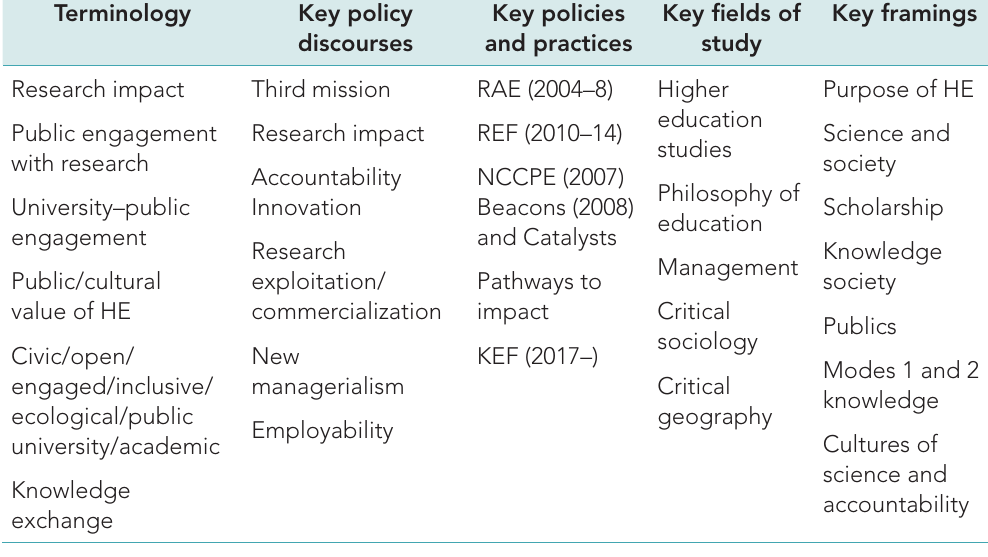
Table 1: Approaches to research engagement within the higher education domain Terminology Key policy Key policies Key fields of Key discourses and practices study